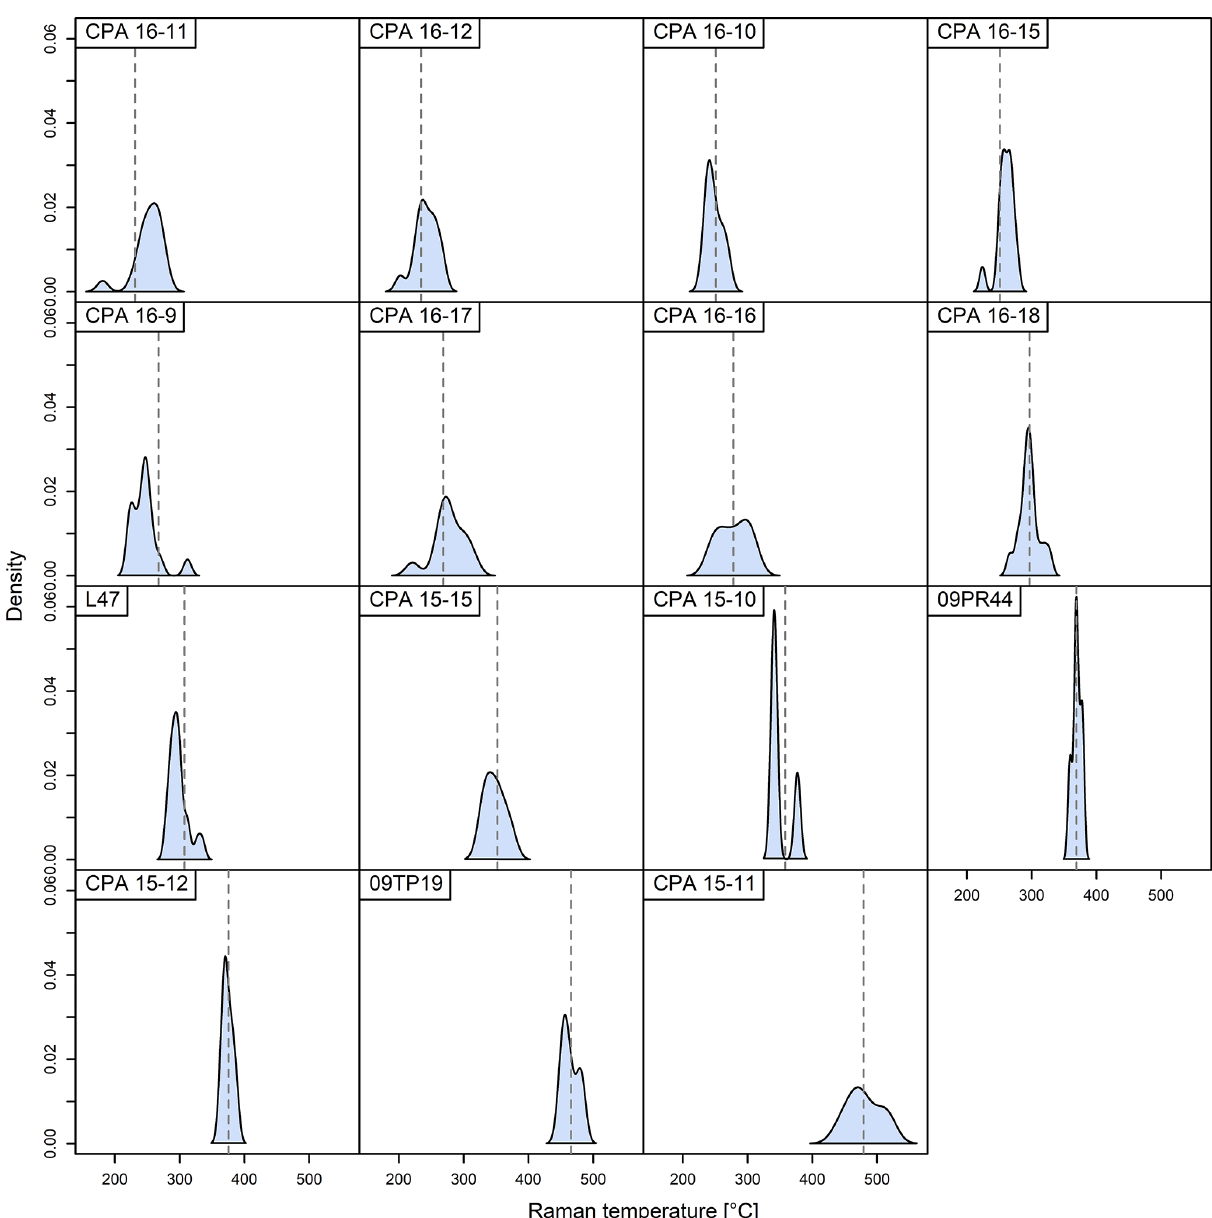
Figure 4. Density distribution of temperatures obtained from Raman spectroscopy of carbonaceous matter from the Torres del Paine intrusion, ordered by increasing temperature. Sample name is given in top left corner of each panel; the dashed grey line indicates the